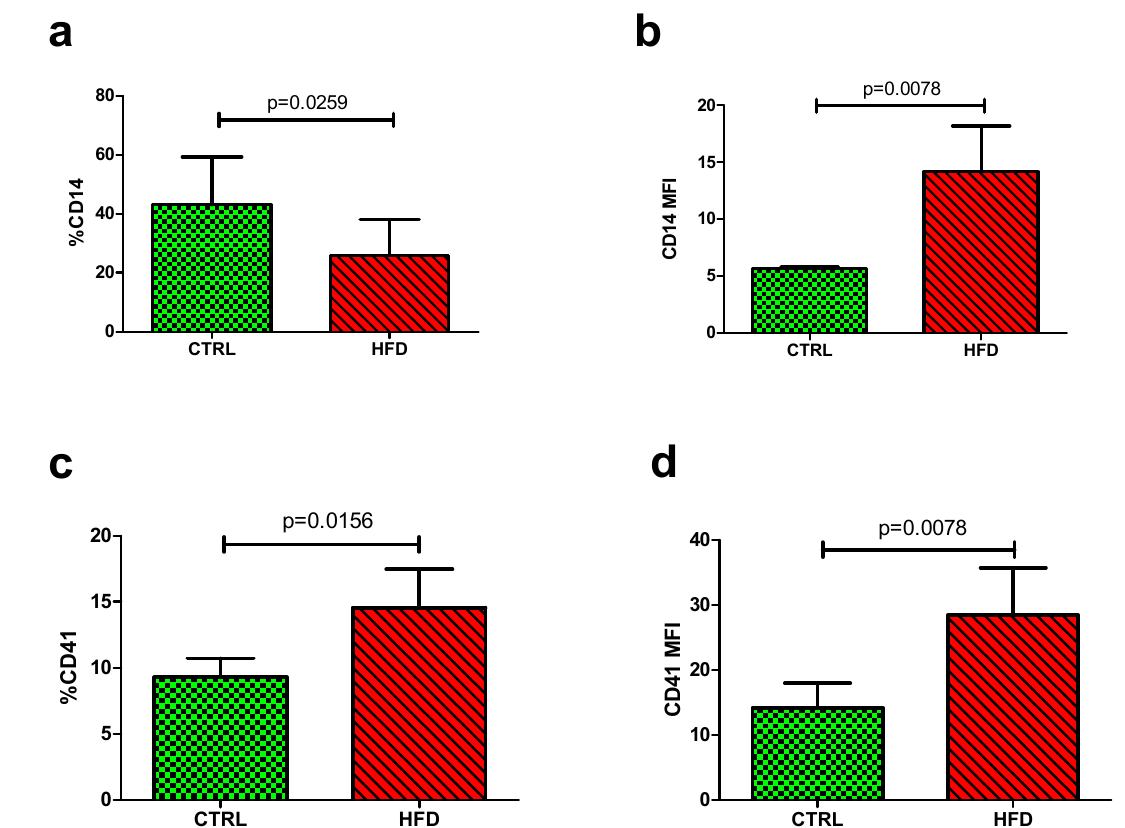
Figure 2. Baseline monocyte and platelet-monocyte aggregate levels between the control (CTRL) group and the high-fat diet (HFD) group. ( a ) Monocyte levels (%CD14) were significantly lower in the HFD group compared to the control group at baseline, p = 0.0259. ( b ) The qualitative measurement (CD14 MFI) however was increased in the HFD compared to the control group, p = 0.0078. PMAs were determined by the level of platelet-bound monocytes. ( c ) The HFD group had higher levels of PMA compared to the control group at baseline measurement, p = 0.0156. ( d ) Similarly, the qualitative measurement (CD41 MFI) was increased in the HFD compared to the control group, p = 0.0078. PMA: platelet-monocyte aggregate; HFD: high-fat diet; MFI: median fluorescence intensity.